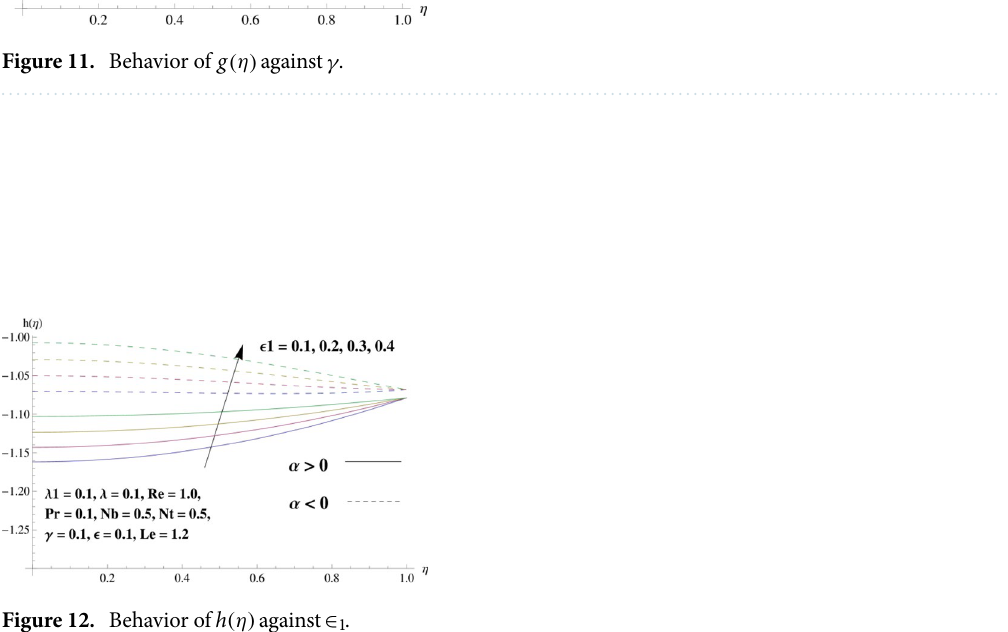
Figure 12. Behavior of h (η) against